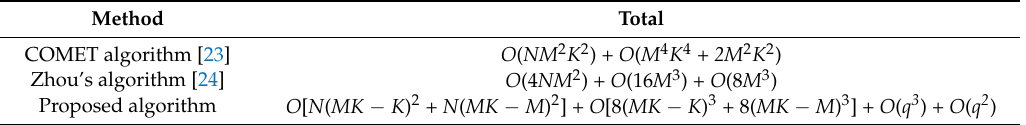
Table 1. Computational complexity of different